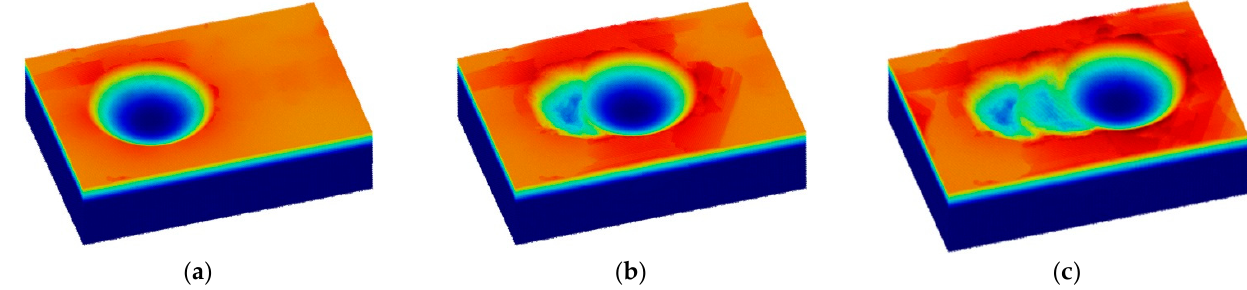
Figure 6. 3D images of the titanium crystallite after one ( a ), two ( b ) and three ( c ) penetrations of the spherical indenter.